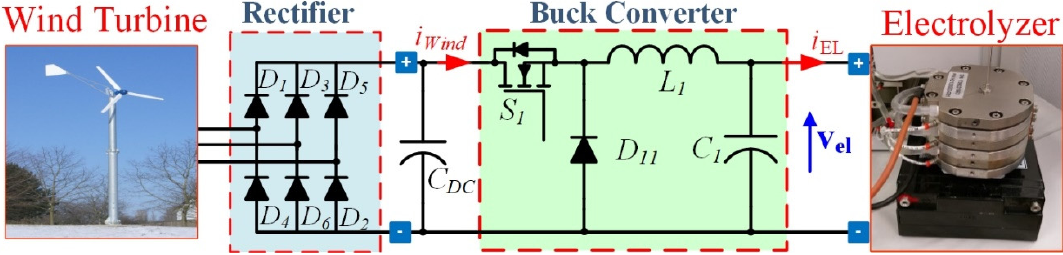
Figure 5. Hydrogen production systems supplied by wind energy with uncontrolled rectifier as passive front-end.